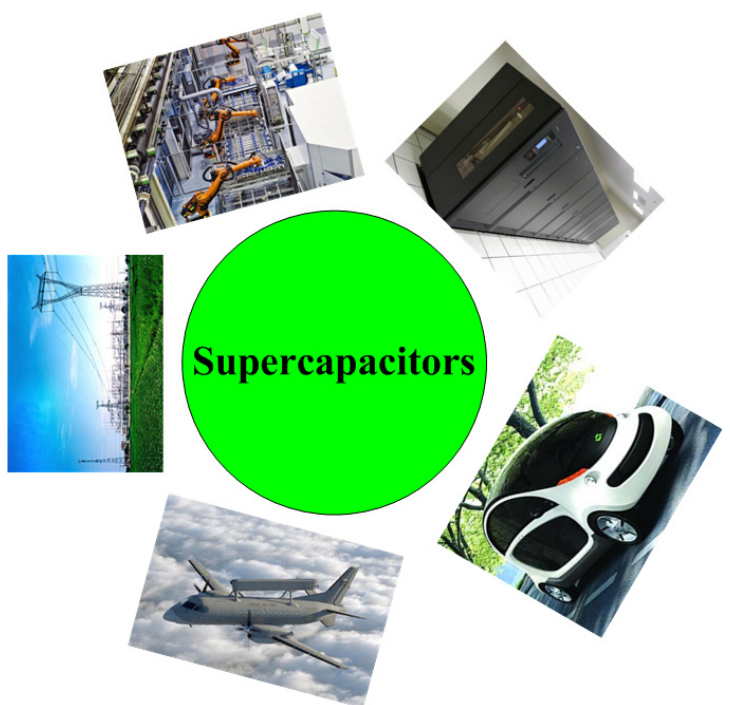
Figure 1. Some possible applications of supercapacitors in today’s